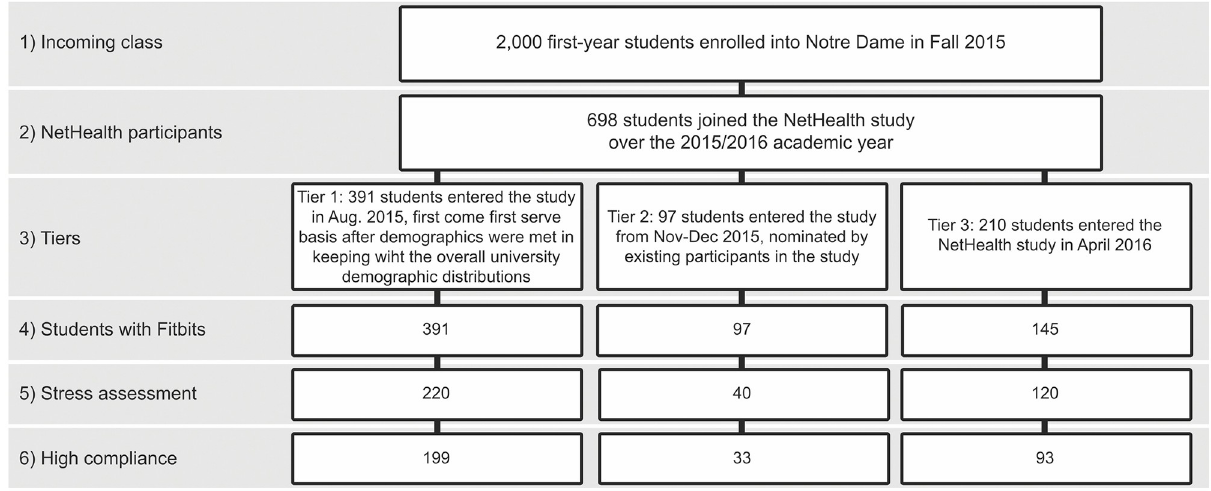
Fig 3. Consort diagram of NetHealth recruitment and students selected for this